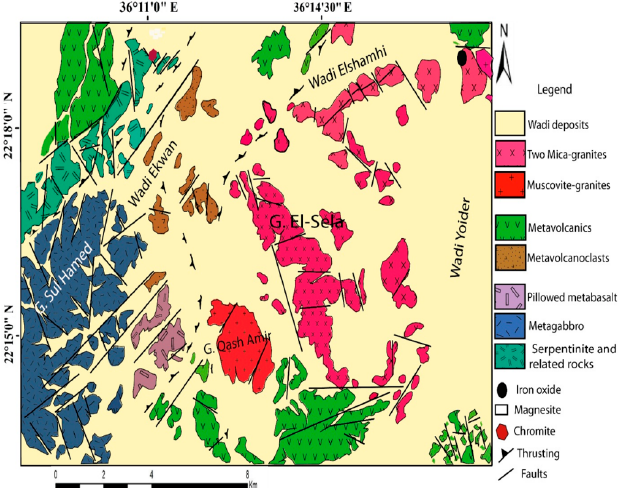
Figure 1. Geologic map of El Sella area [22].